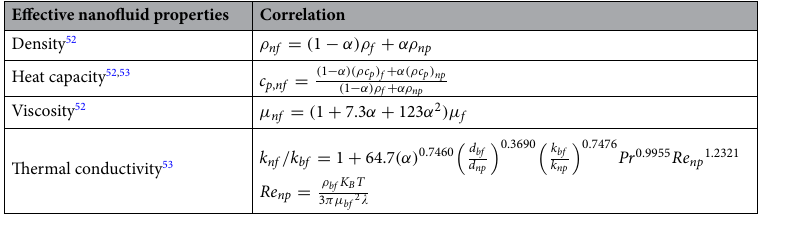
Table 1. Al 2 O 3 /water